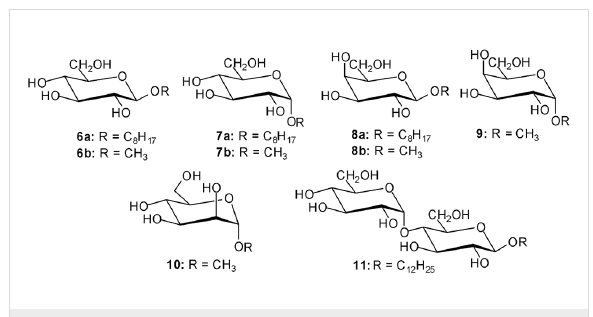
Figure 3: Structures of sugars investigated in this